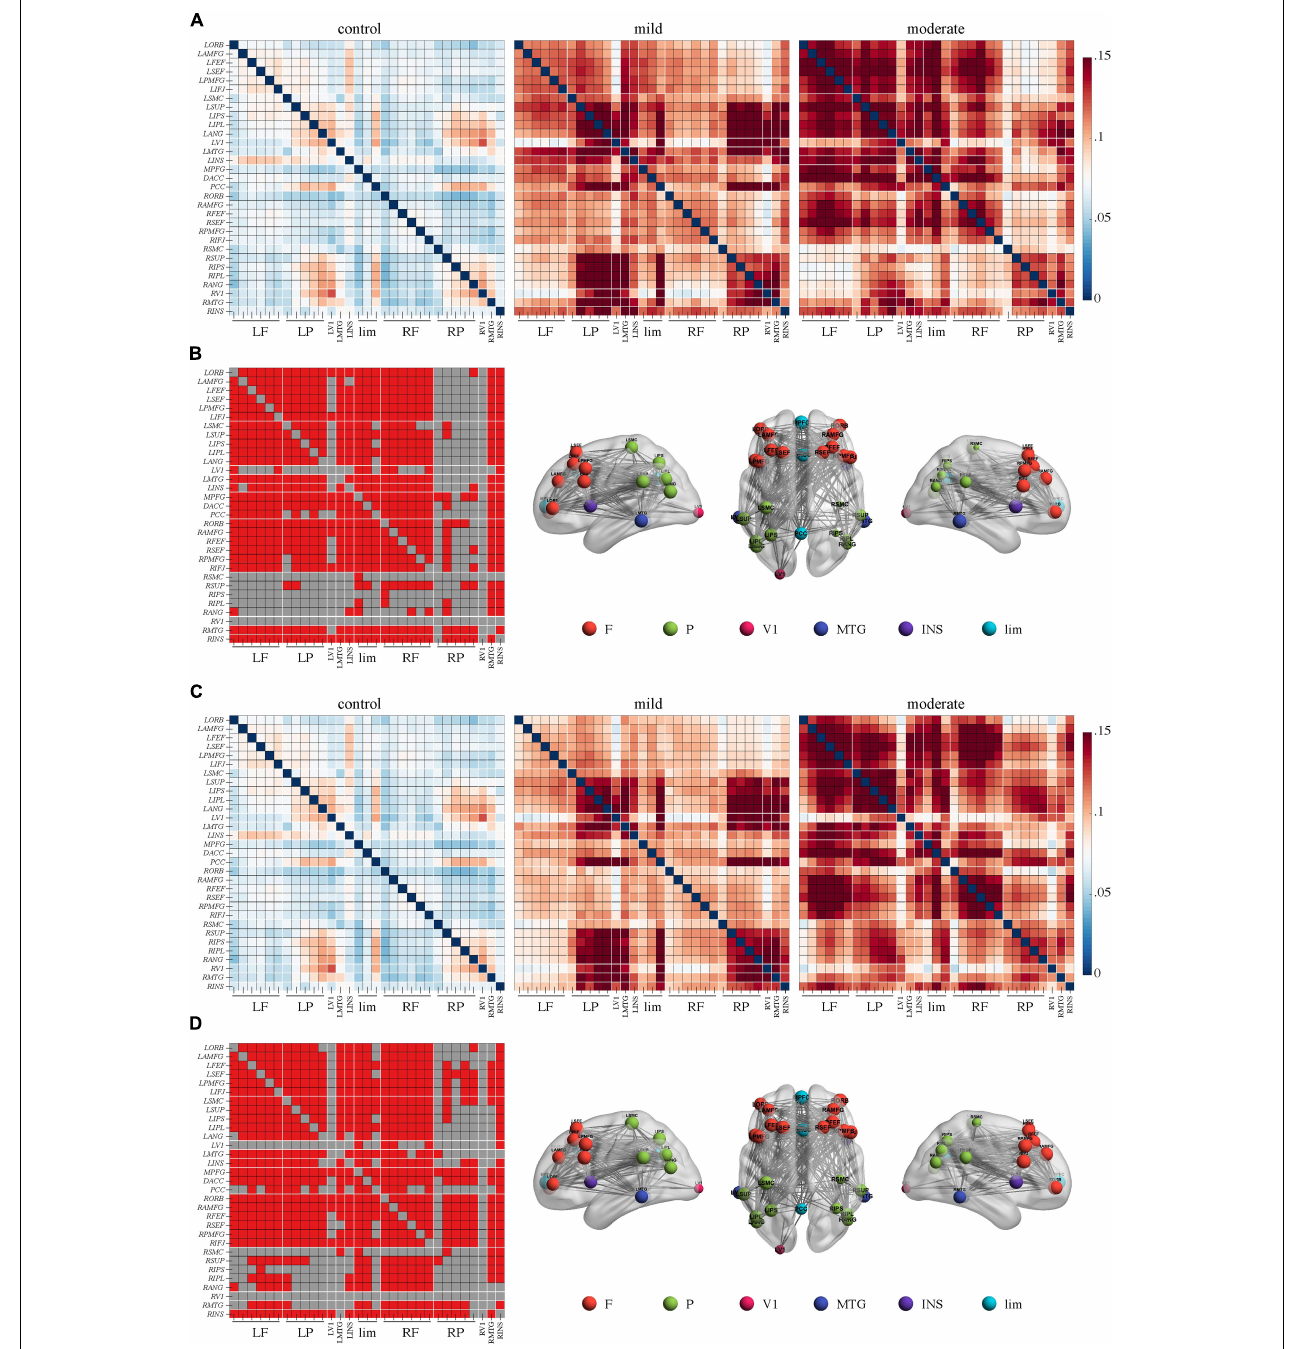
FIGURE 2 | Higher connectivity in the theta band in Alzheimer’s disease patients with moderate cognitive impairment before and after repetitive transcranial magnetic stimulation (rTMS). (A) Power envelope connectivity matrices of the control, mild, and moderate groups pre-rTMS. (B) The network-based statistics results of moderate group > control group pre-rTMS. (C) Power envelope connectivity matrices of the control, mild, and moderate groups post-rTMS. (D) The network-based statistics results of moderate group > control group post-rTMS. In (B,D) , the connectivity difference matrix (left panel) and its three-dimensional visualization (right panel) are shown. The three-dimensional visualization shows the left, up, and right views of the brain. The meaning of the red squares, size of node, and all abbreviations are the same as in Figure 1 .